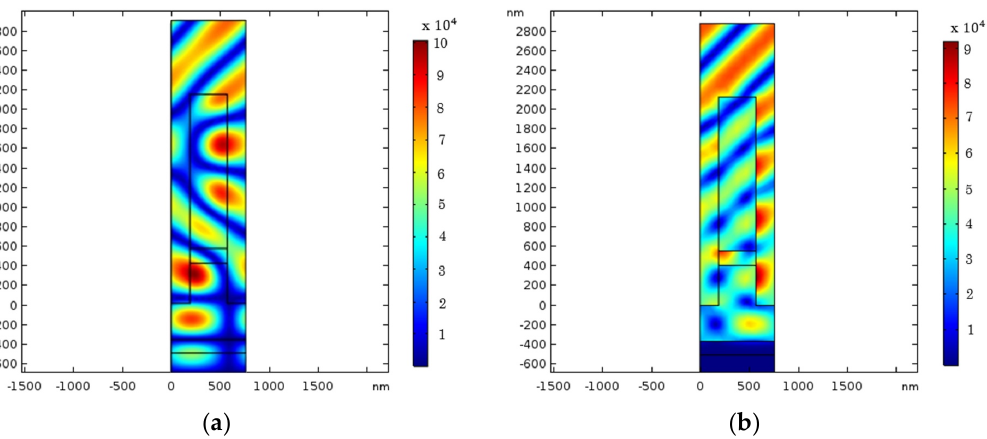
Figure 8. Normalized electric field distribution for ( a ) TE polarization and ( b ) TM polarization. Table 2. Parameter of the three-layer MDG.